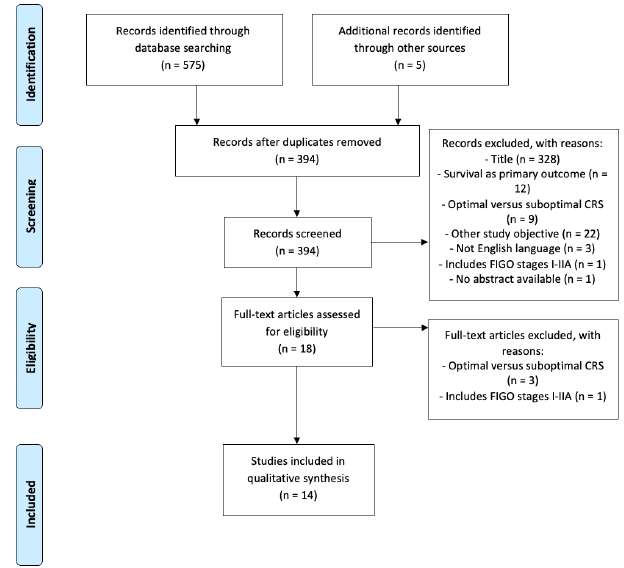
Figure 1. Flowchart of study selection.